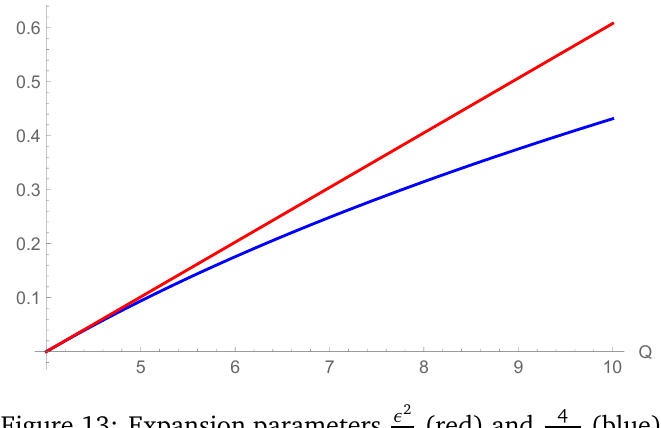
Figure 13: Expansion parameters